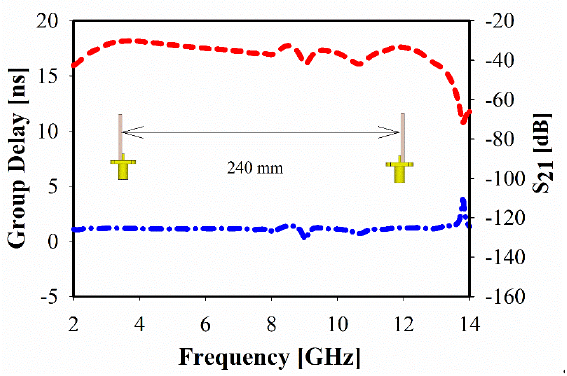
Figure 16. Group delay response of face-to-face position.